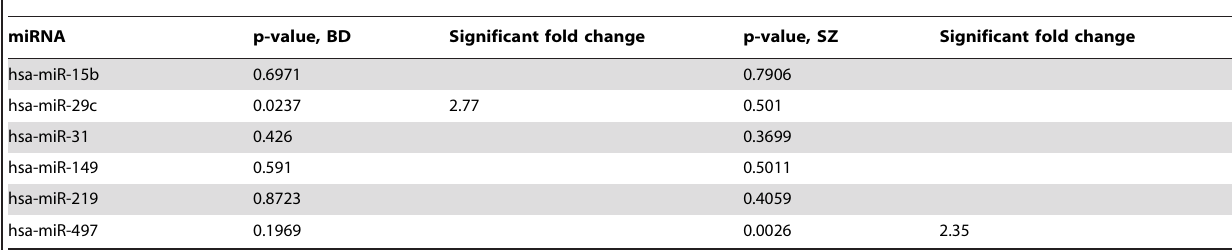
Table 9. Student’s t-test comparison of qPCR